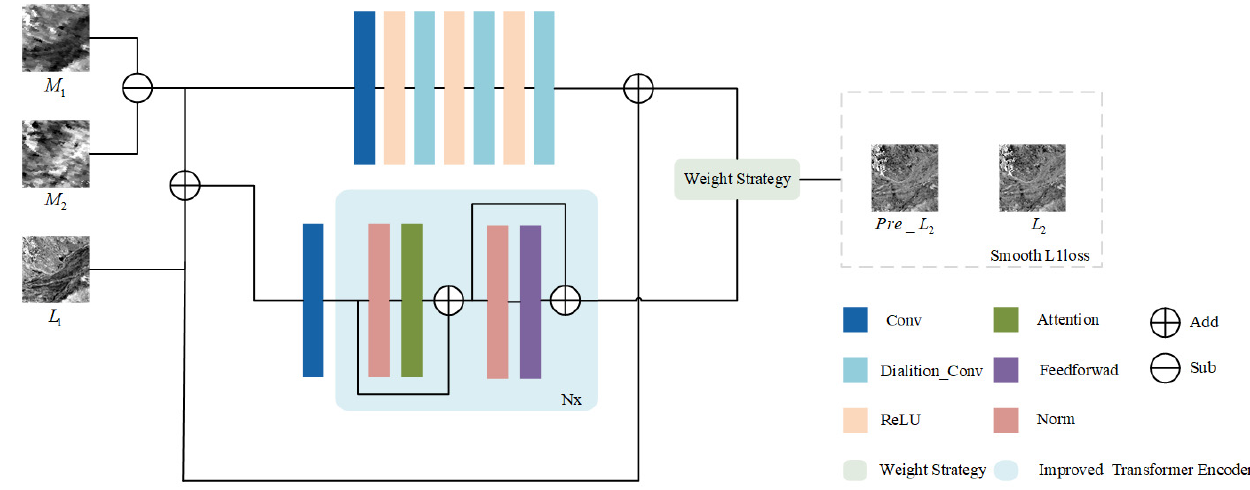
Figure 1. EMSNet architecture.